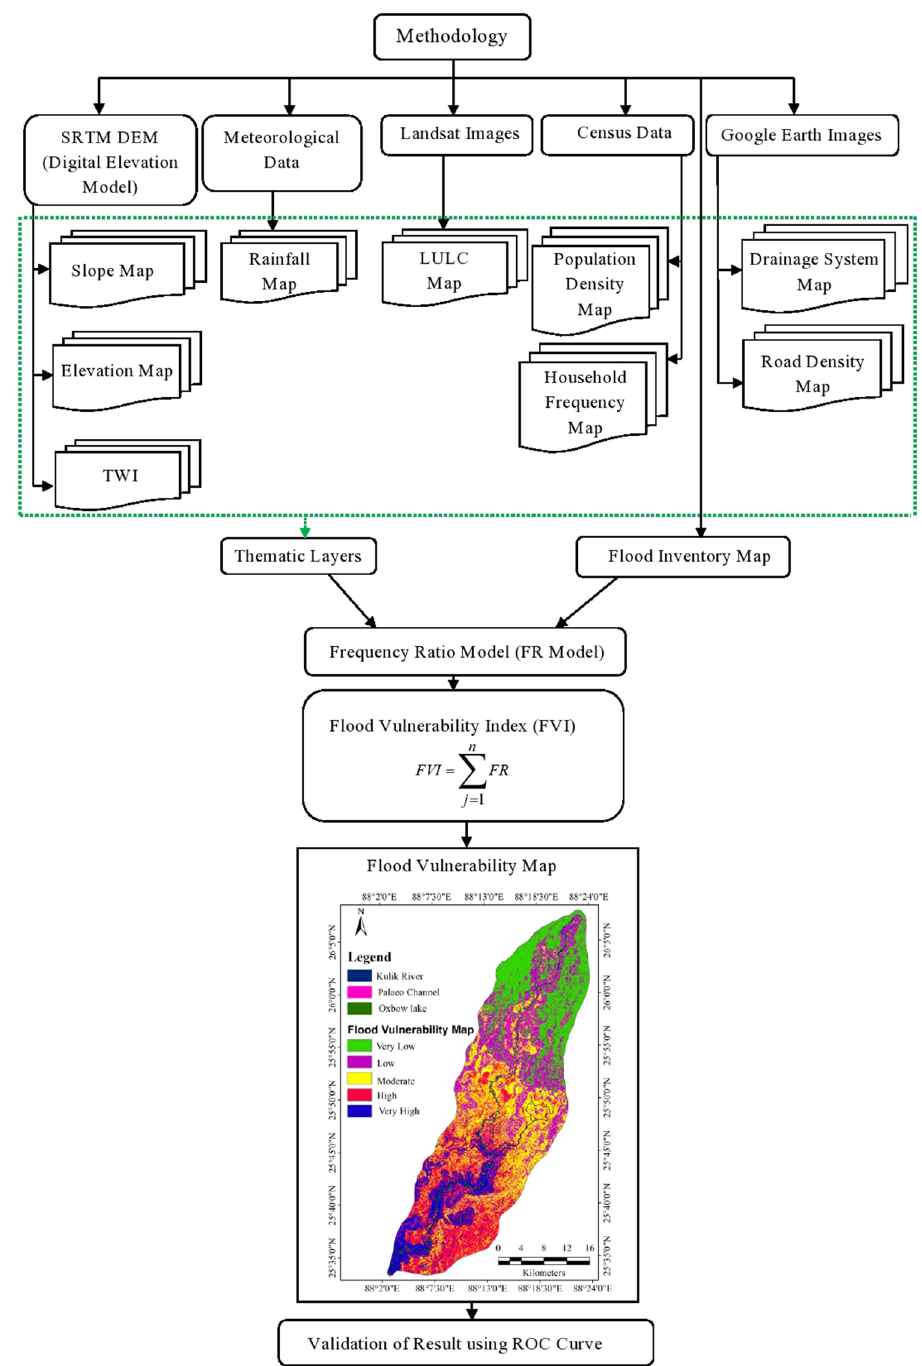
Fig. 2 Flow chart and meth- odology for preparing flood vulnerability